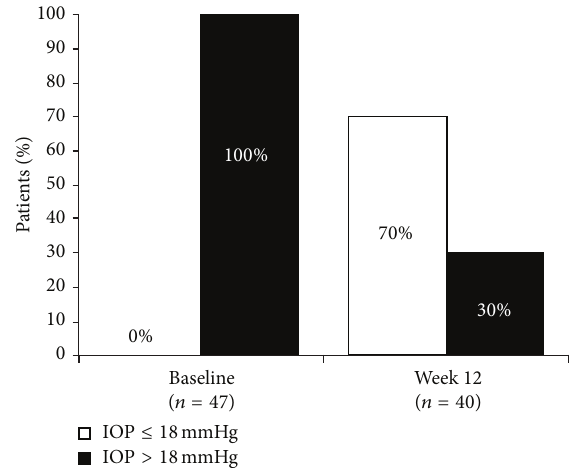
Figure 2: Percentage of patients with IOP ≤ 18mmHg and > 18mmHgatbaselineandweek12.Patientpercentagesareindicated inside bars. IOP = intraocular